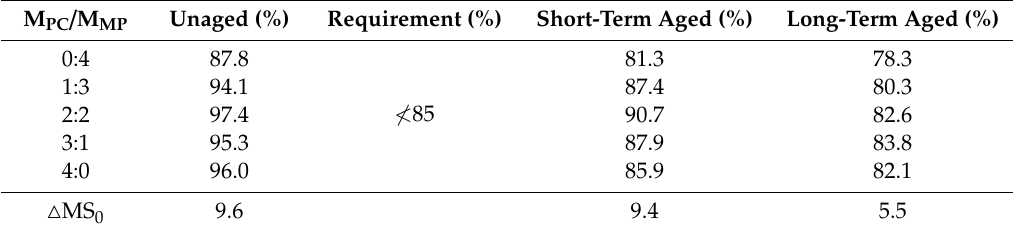
Table 8. Residual stability ratio (MS 0 ) in immersed Marshall test for di ff erent aging degrees